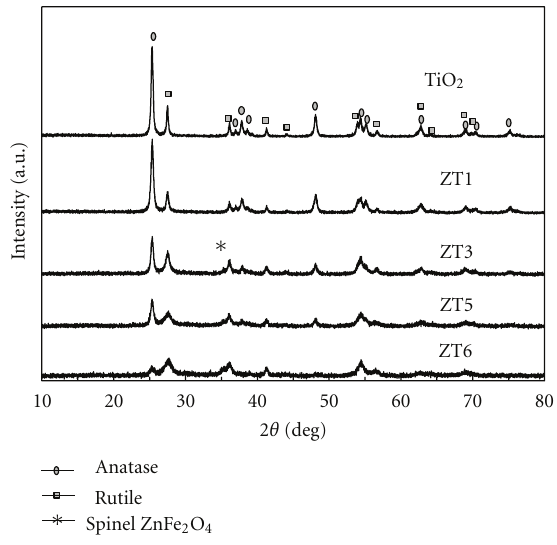
Figure 1: WAXRD patterns of pure TiO 2 and ZT series